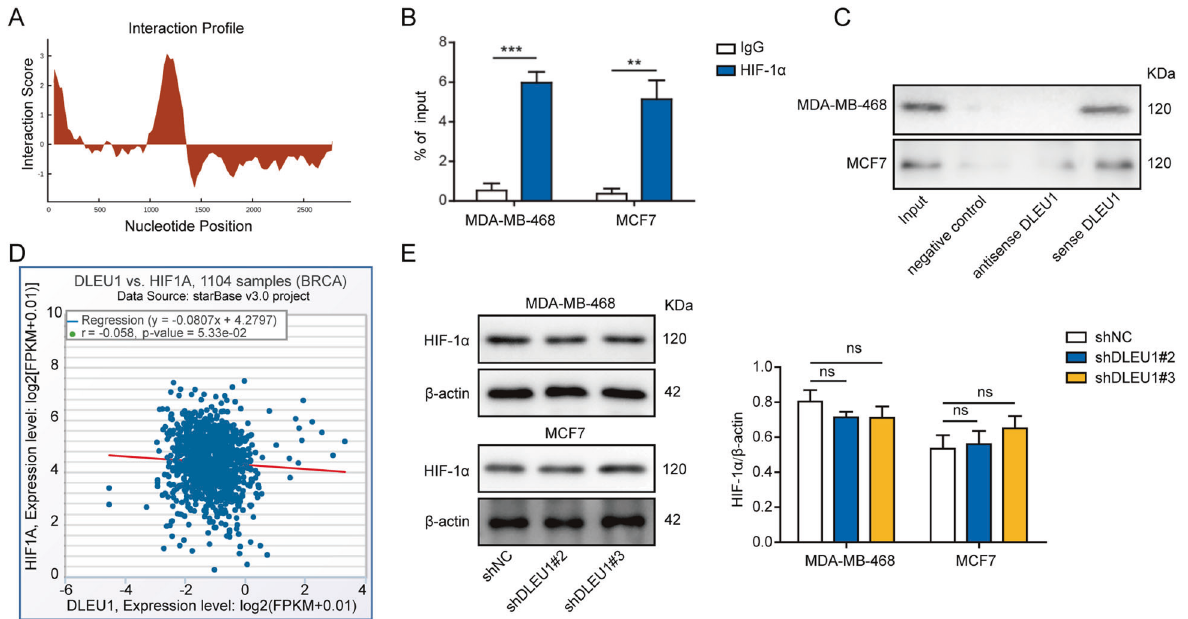
Fig. 4 DLEU1 directly interacts with but not controls the expression of HIF-1 α . A The interaction between DLEU1 and HIF-1 α was analyzed using catRAPID algorithm. B The interaction between DLEU1 and HIF-1 α was examined by RIP assay in MDA-MB-468 and MCF7 cells. The amount of immunoprecipitated DLEU1 was presented as a % of total input. C The interaction between DLEU1 and HIF-1 α was examined by RNA pull-down assay in MDA-MB-468 and MCF7 cells using negative control, sense DLEU1, or antisense DLEU1 as the probe. D Analysis of TCGA database revealed no signi fi cant correlation between DLEU1 and HIF-1 α expression levels in breast cancer tissues ( n = 1104). E MDA- MB-468 and MCF7 cells were stably transfected with shNC, shDLEU1#2, or shDLEU1#3. HIF-1 α level was detected by western blot. ** P < 0.01, *** P < 0.001, and ns not signi fi